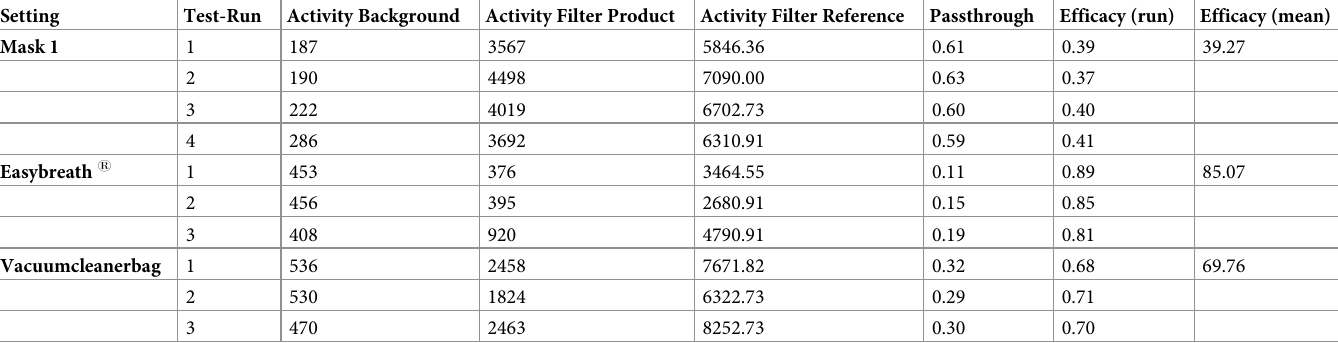
Table 1. Results of the measurements. This table shows the results of the measurements of the three home-made and modified masks.